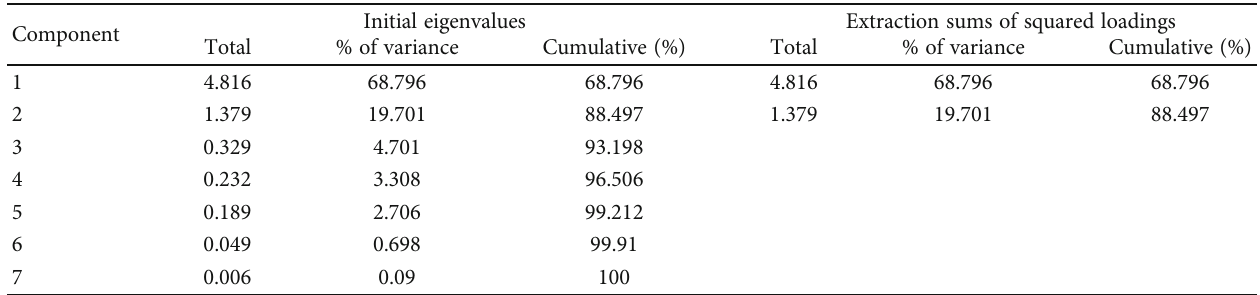
Table 6: Total variance explained by the PCA.